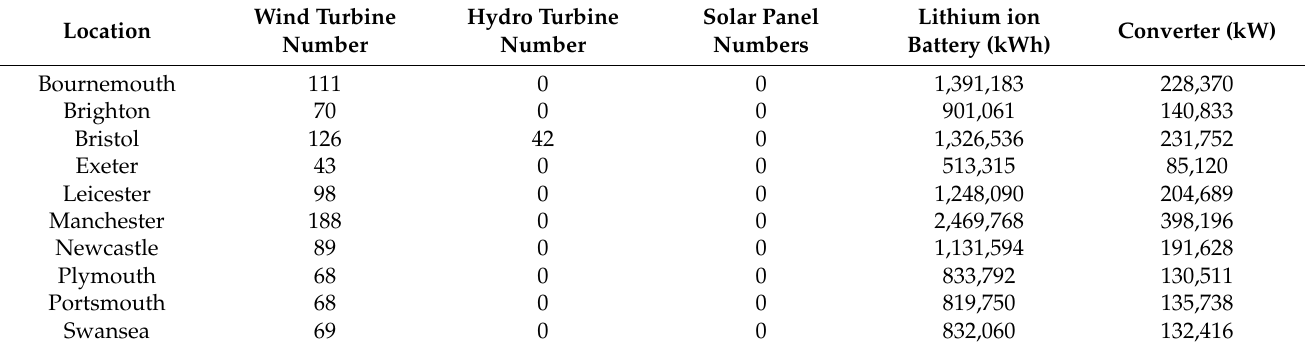
Table 11. Architecture of lowest Net Present Cost